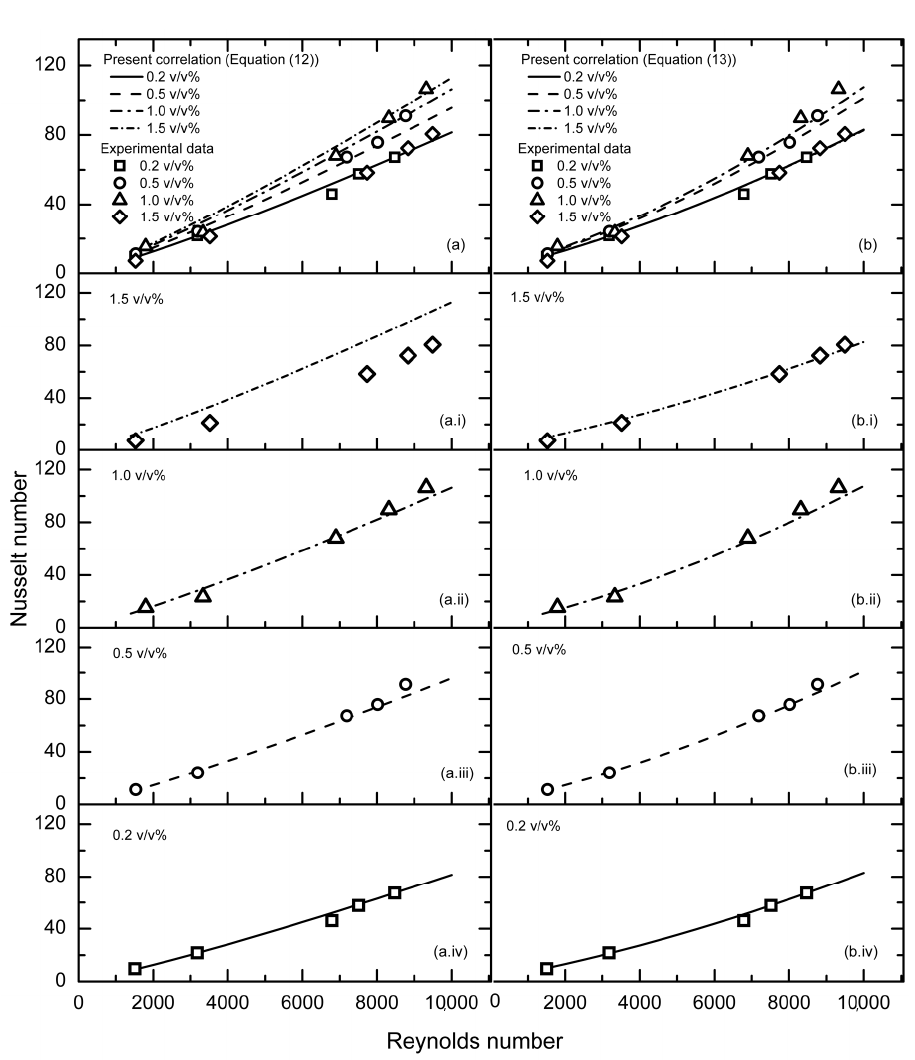
Figure 12. Plots of N Nu versus N Re . The symbols are the experimental data and the curves were calculated by Equation (12) in ( a – a.iv ) and Equation (13) in ( b – b.iv ). Cumulative results ( a , b ), and the results of NFs with a NP concentration of 1.5 v / v % ( a.i , b.i ), 1.0 v / v % ( a.ii , b.ii ), 0.5 v / v % ( a.iii , b.iii ), and 0.2 v / v % ( a.iv , b.iv ). Legends as shown in ( a , b